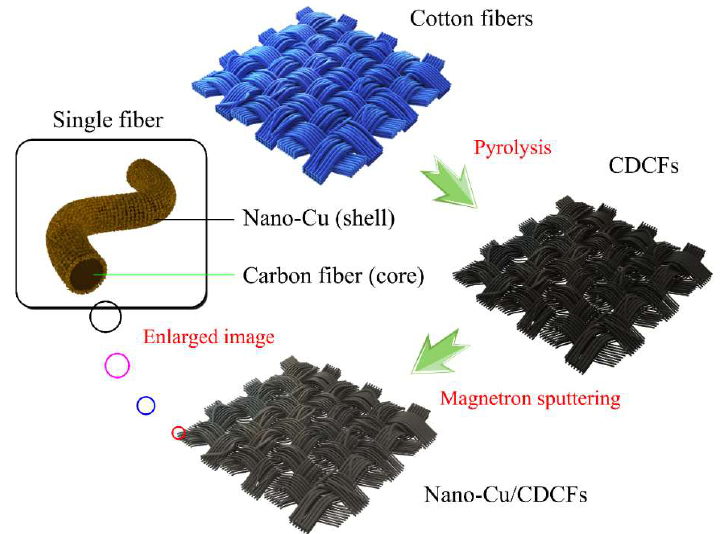
Figure 1. Graphical illustration of the design concept of the core–shell structured nano-Cu/CDCFs composite.